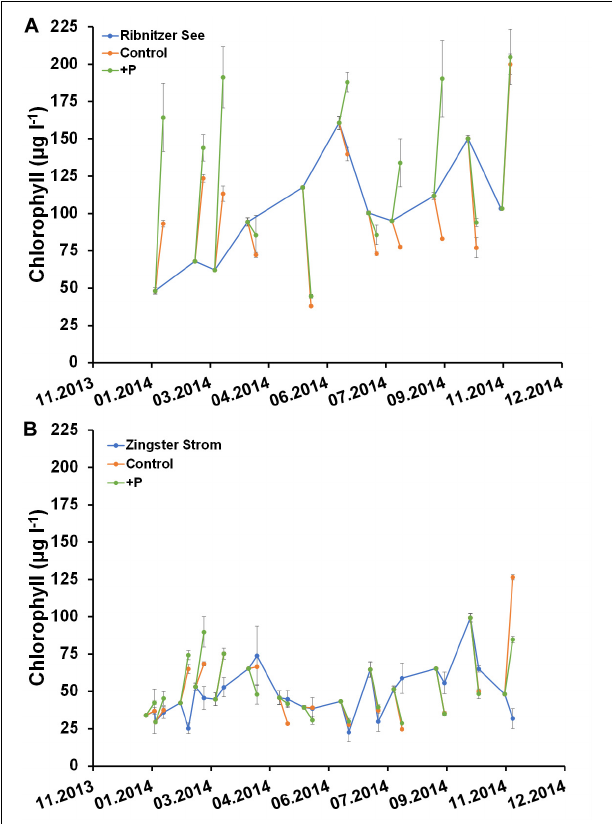
FIGURE 7 | Comparison of seston concentration (mg l − 1 ) in unfertilized (control) and fertilized (+P) samples after 7 days and the actual ecosystem (Ribnitzer See and Zingster Strom) in 2014. Samples were fertilized with a 10 µ mol l − 1 DIP pulse (final concentration) at day 0. Treatments with waters of the Ribnitzer See (A) and Zingster Strom (B) were filtrated after 7 days of incubation. Additionally, Chlorophyll-values from the actual ecosystem (only Zingster Strom) were included as weekly average. Incubation in batch tanks at 15 ◦ C ( ± 1 ◦ C), photon flux 100 µ mol photons m − 2 s − 1 , light:dark 16:8 h. Error bars in A and B are calculated as standard deviation ( n =